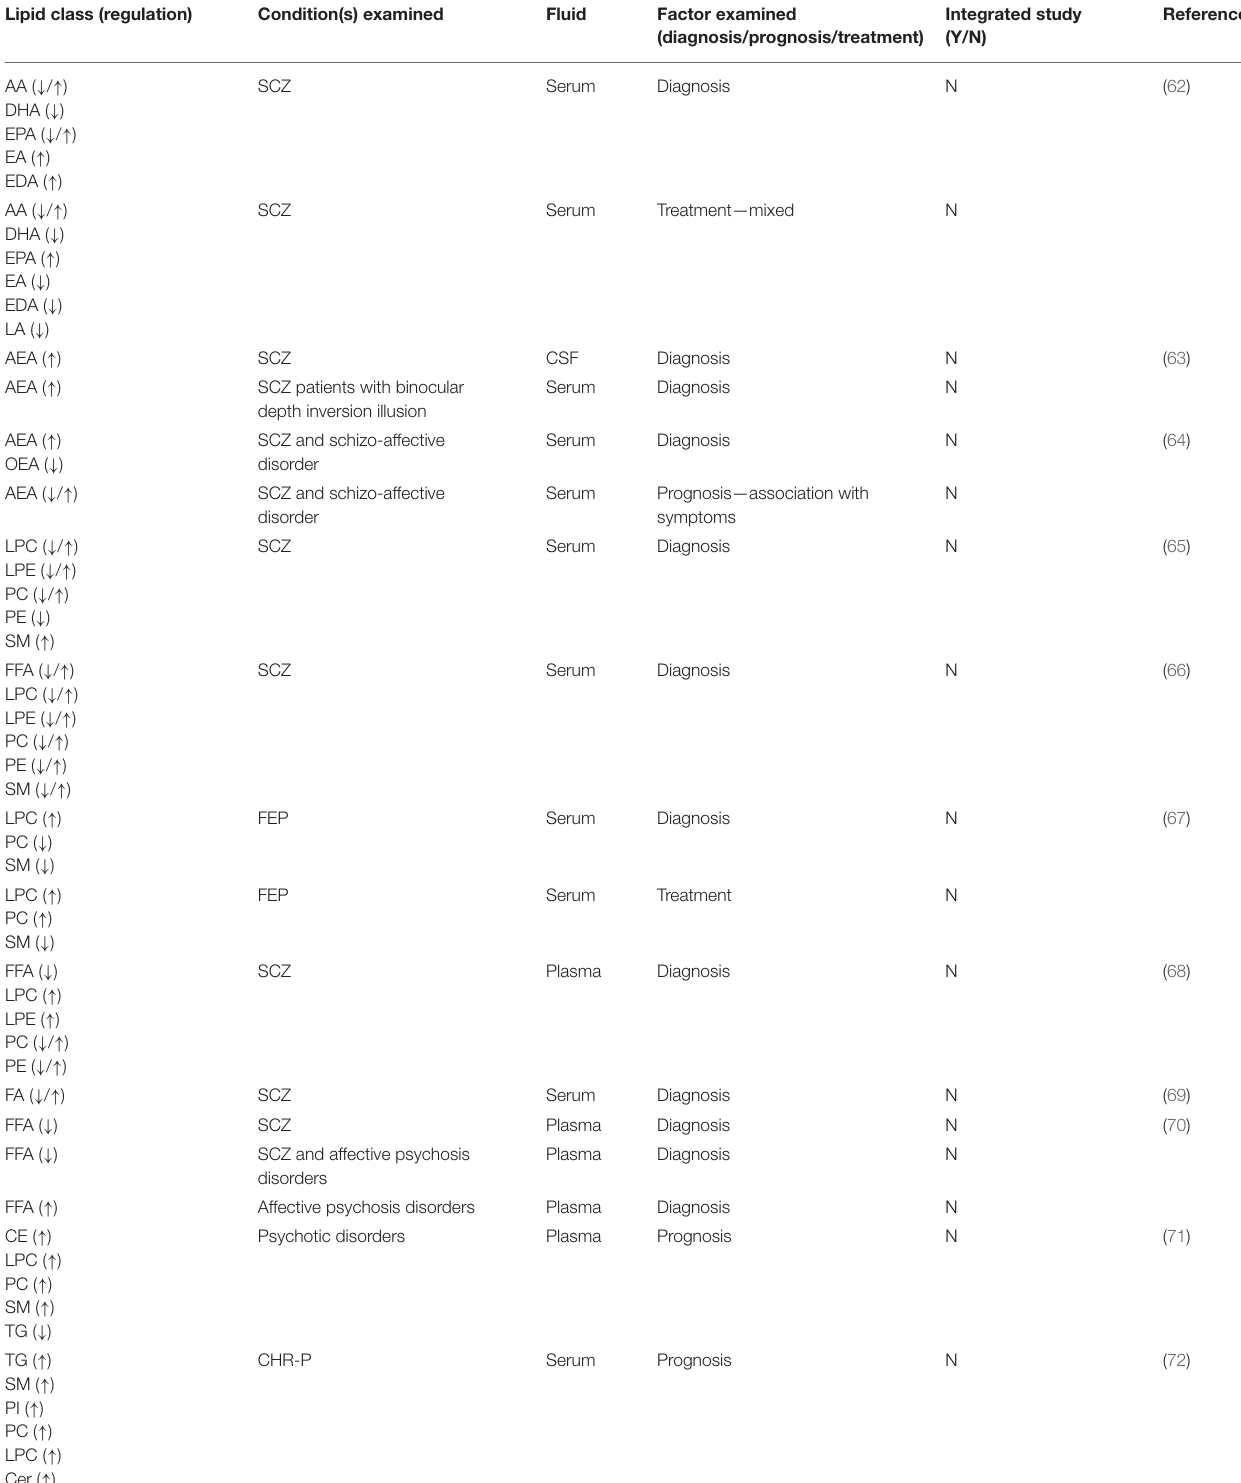
TABLE 1 | Summary of identified lipid alterations in SSD and related psychoses. Lipid class